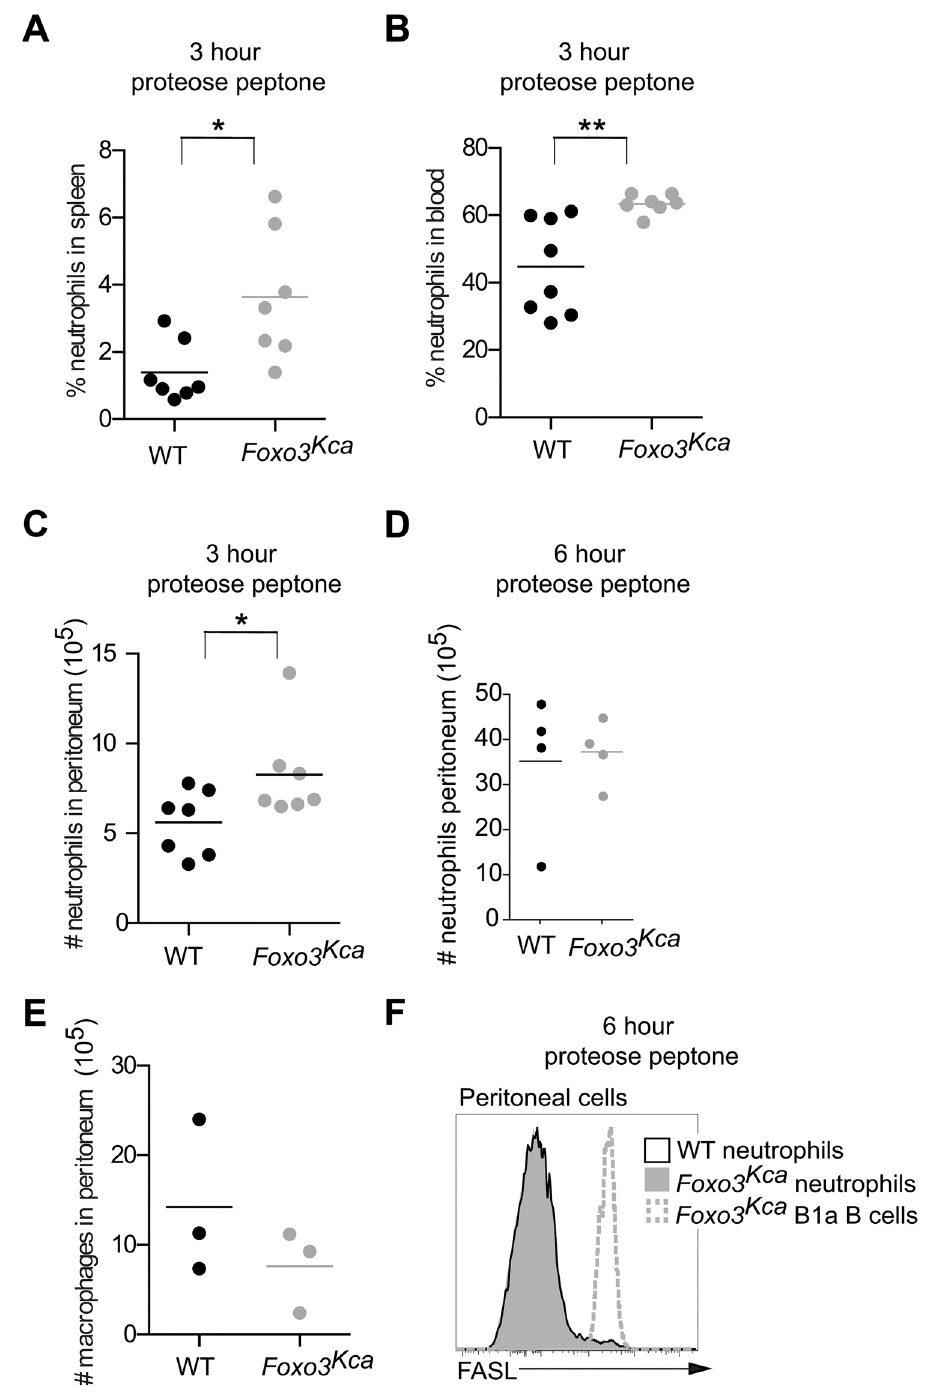
Fig 3. Neutrophils accumulate to a normal level in Foxo3 Kca mice during peritonitis. (A – D) WT or Foxo3 Kca mice were injected i.p. with 1 ml of 10% proteose peptone to induce peritonitis. Flow cytometry was used to identify neutrophils present in the (A) spleen, (B) blood, and (C) peritoneum 3 hr post proteose peptone injection. Data shown were pooled from two independent experiments. (D) The number of peritoneal neutrophils was determined 6 hr post proteose peptone injection. Data are representative of three independent experiments with at least three mice per group. (E) The number of F4/80 hi macrophages in the peritoneum of untreated mice was determined by flow cytometry. (F) Histograms show surface FASL expression on peritoneal neutrophils (LY6G + SSC hi cells) from WT (open black histogram) and Foxo3 Kca